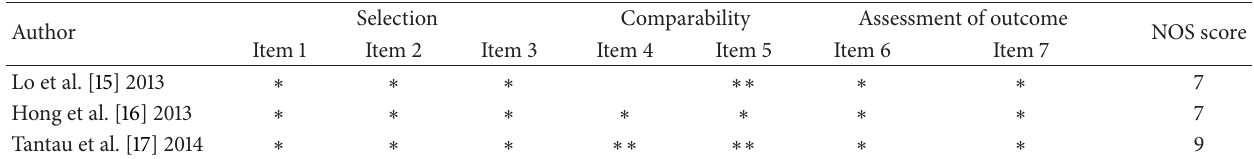
Table 2: Methodological quality of nonrandomized studies.